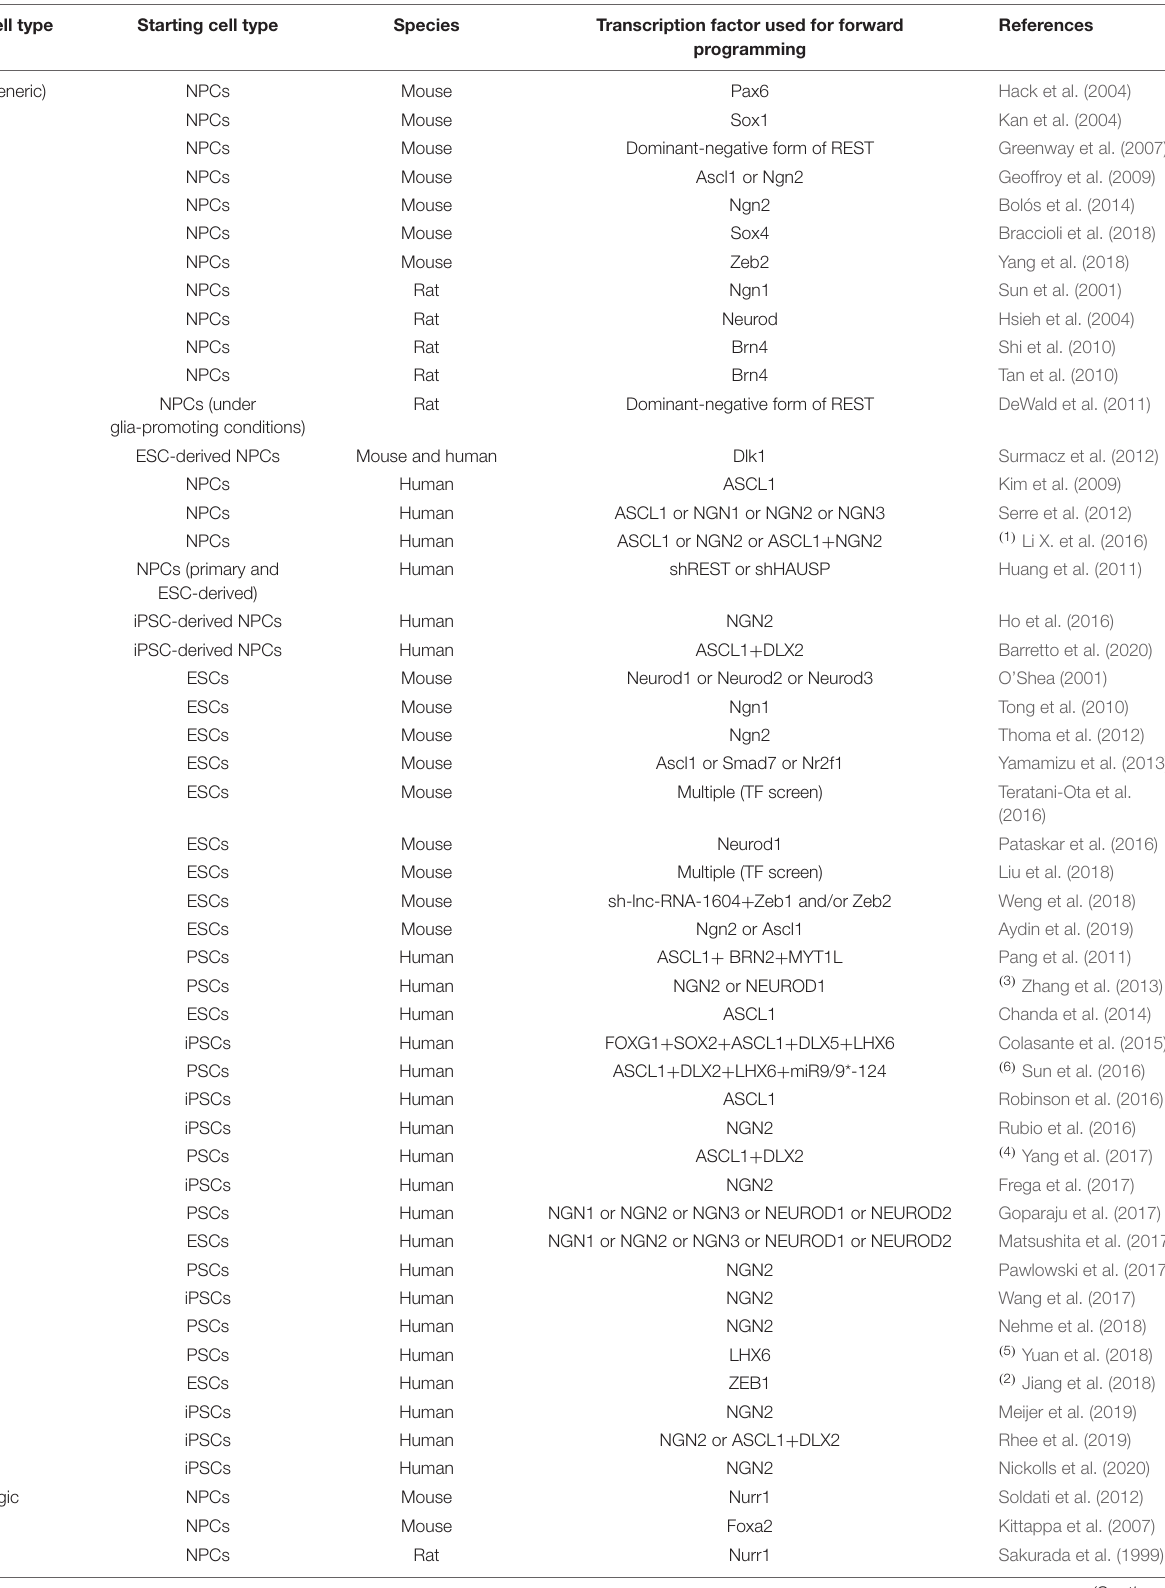
TABLE 1 | Transcription factors used for promoting neuronal differentiation of neural precursor cells and pluripotent stem cells in vitro . Desired cell